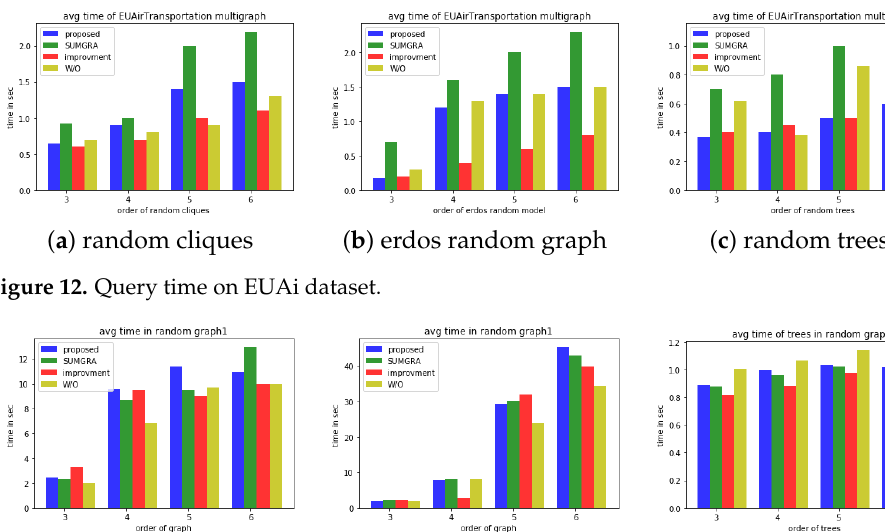
Figure 11. Query time on plasmodium dataset.